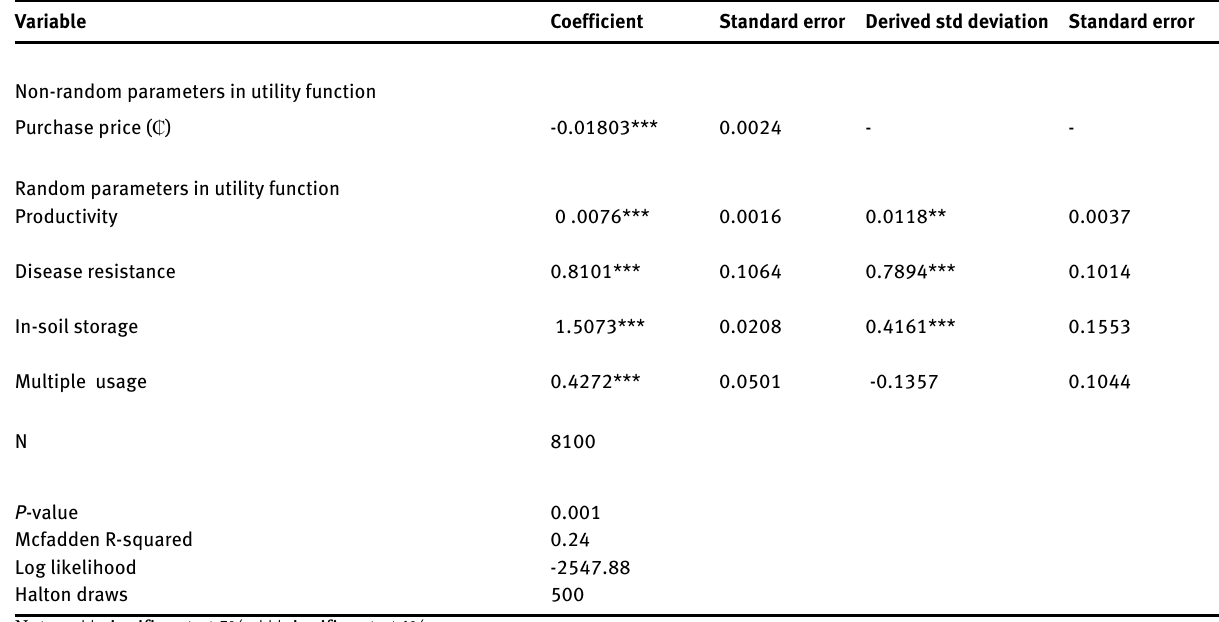
Table 4: Simulated maximum likelihood estimates for cassava preferences from mixed